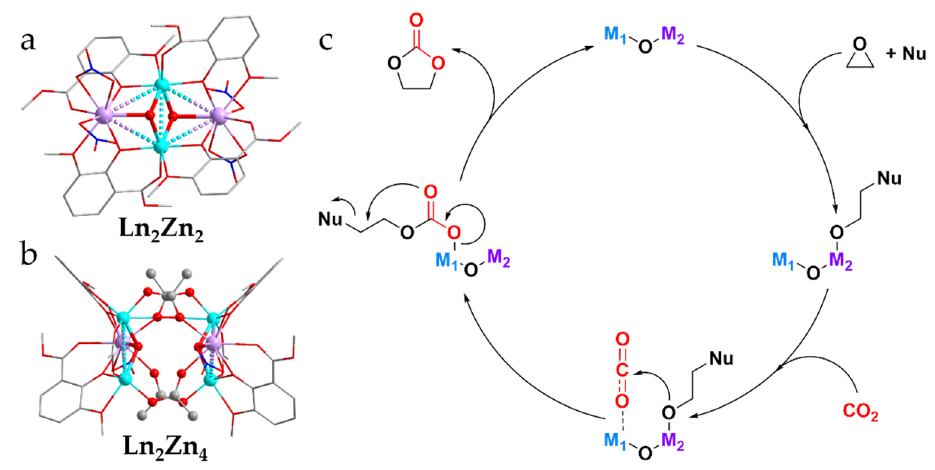
Figure 4. ( a ) The structure of cluster Ln 2 Zn 2 . ( b ) The butterfly-shaped structure of cluster Ln 2 Zn 4 . ( c ) Bimetallic pathway with simultaneous activation of epoxide and CO 2 on the adjacent metal centers. Color legends: Ln, lavender; Zn, turquoise; O, red; C, gray; N, blue [33].